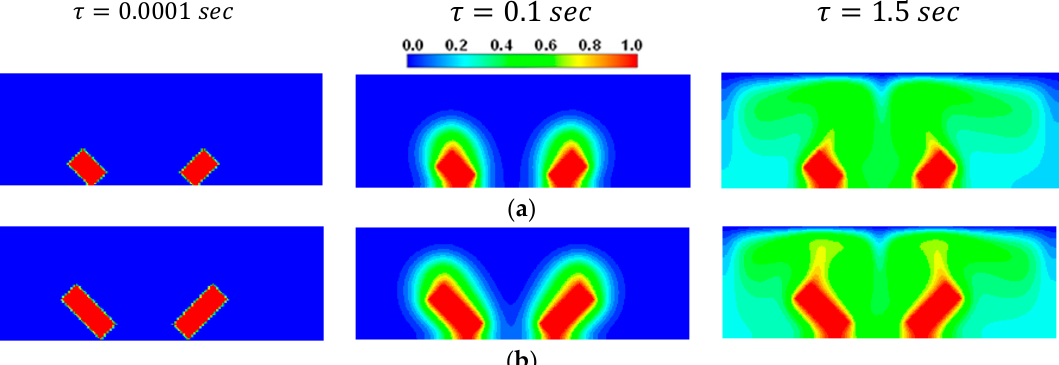
Figure 15. Average Nusselt number under the effects of ( a ) an inclination angle, ( b ) fins lengths with two values of an inclination angle, ( c ) solid volume fraction for hybrid nanofluid, and ( d ) mixture densities ratio with two values of dusty parameter, at Ra = 10 5 and γ = 0.1.